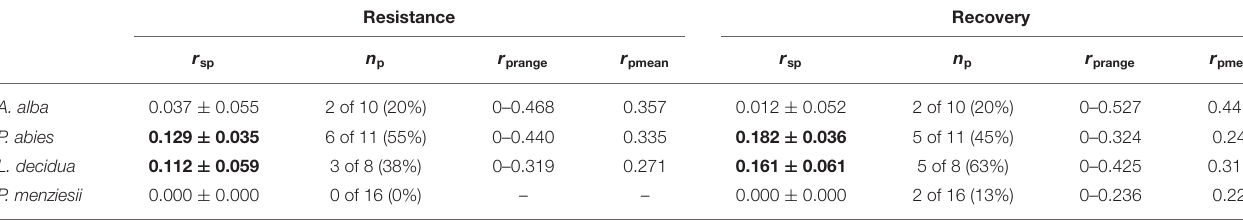
TABLE 5 | Repeatability of resistance and recovery as estimated by the repeatability of drought response across drought events. Resistance